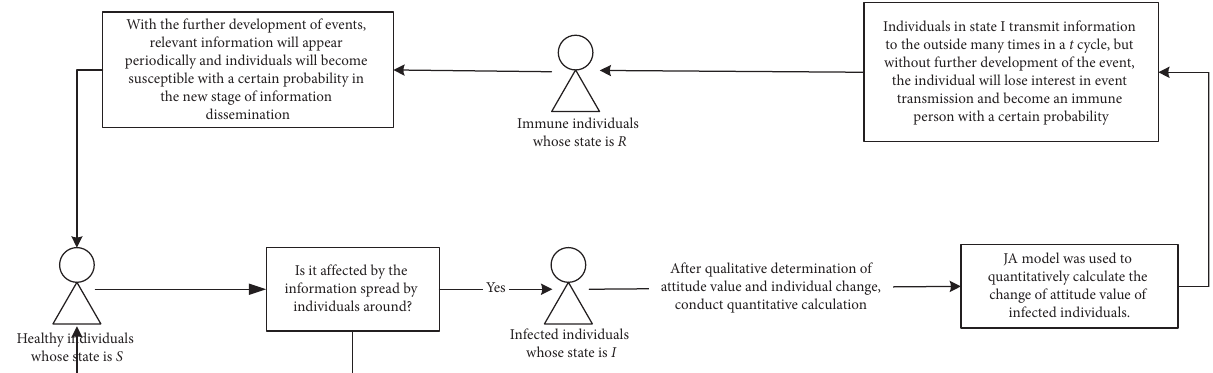
Figure 1: The principle of the polarization model integrated with